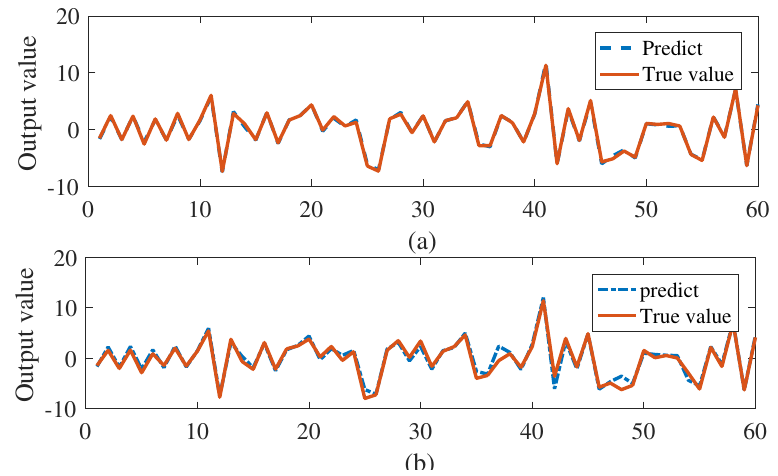
Figure 2. Output of the state mode for 60 testing data in example 1: ( a ) ξ i = 0.1 and ( b ) ξ i = 0.3. Table 1. Accuracy comparison of different methods ( ξ i =